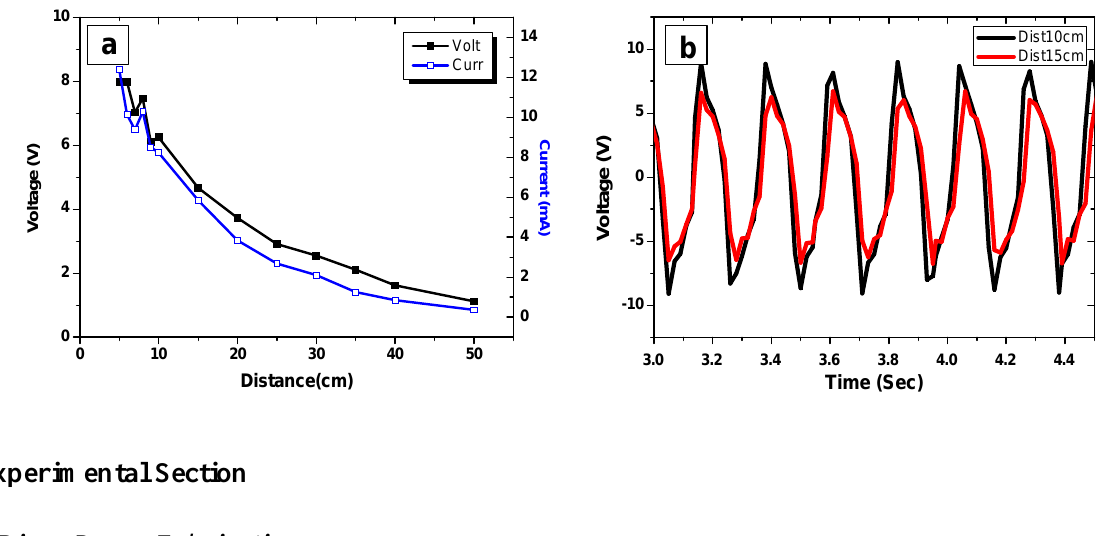
Figure 10. Voltage and current output of rectenna: a) with distance before DAC, b) voltage time signal after DAC.